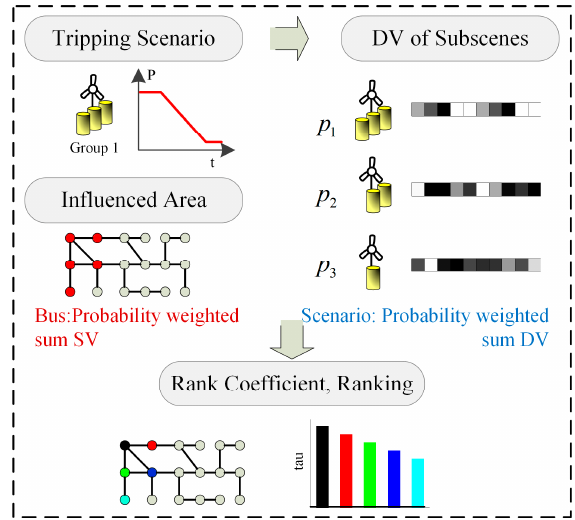
Figure 3. Sites selection for dynamic VAR considering probability of sub-scenario in each zone.